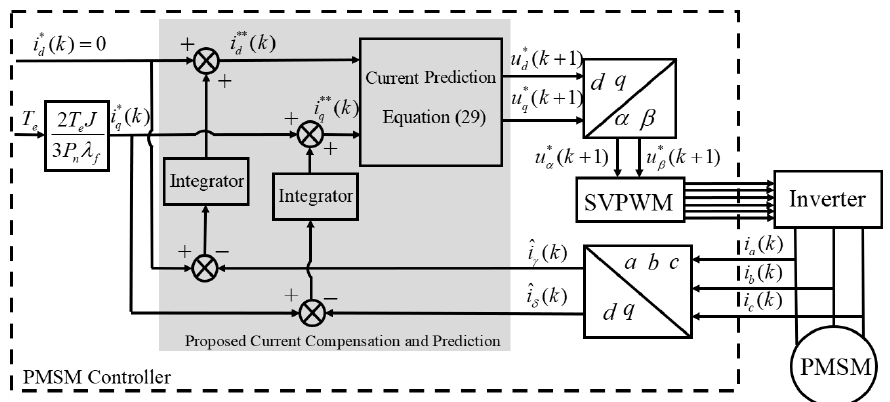
Figure 6. Current compensation within one control period based on closed-loop control of PMSM.